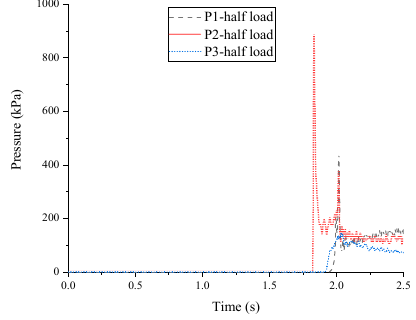
Figure 13. Pressure at P1, P2 and P3 in the case of half load.